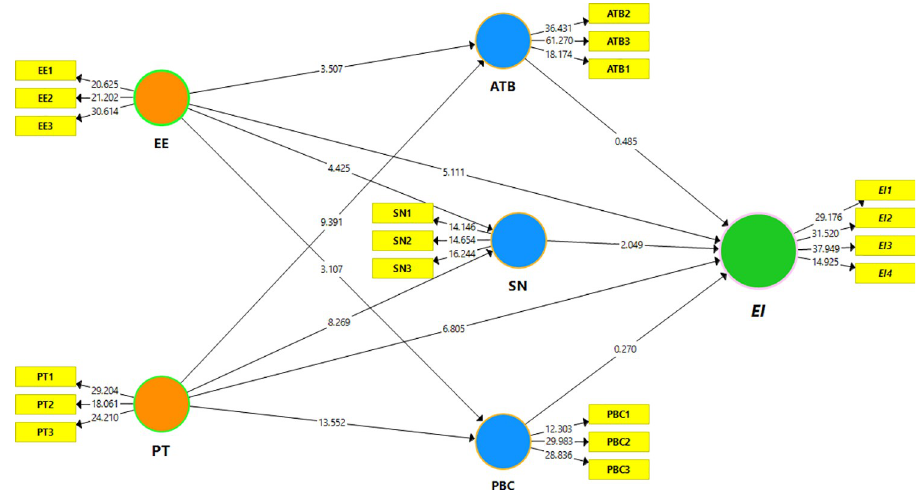
Fig 3. PLS-SEM bootstrapping model significant estimation.